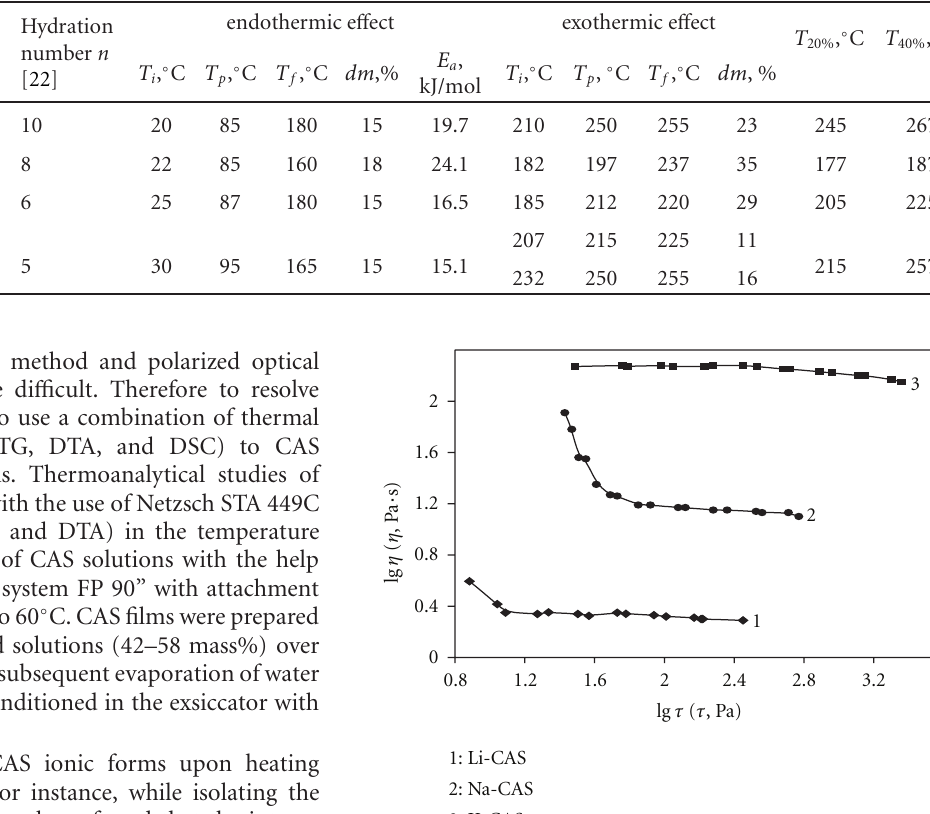
Table 3: Thermal characteristics of film specimens of the CAS salts.